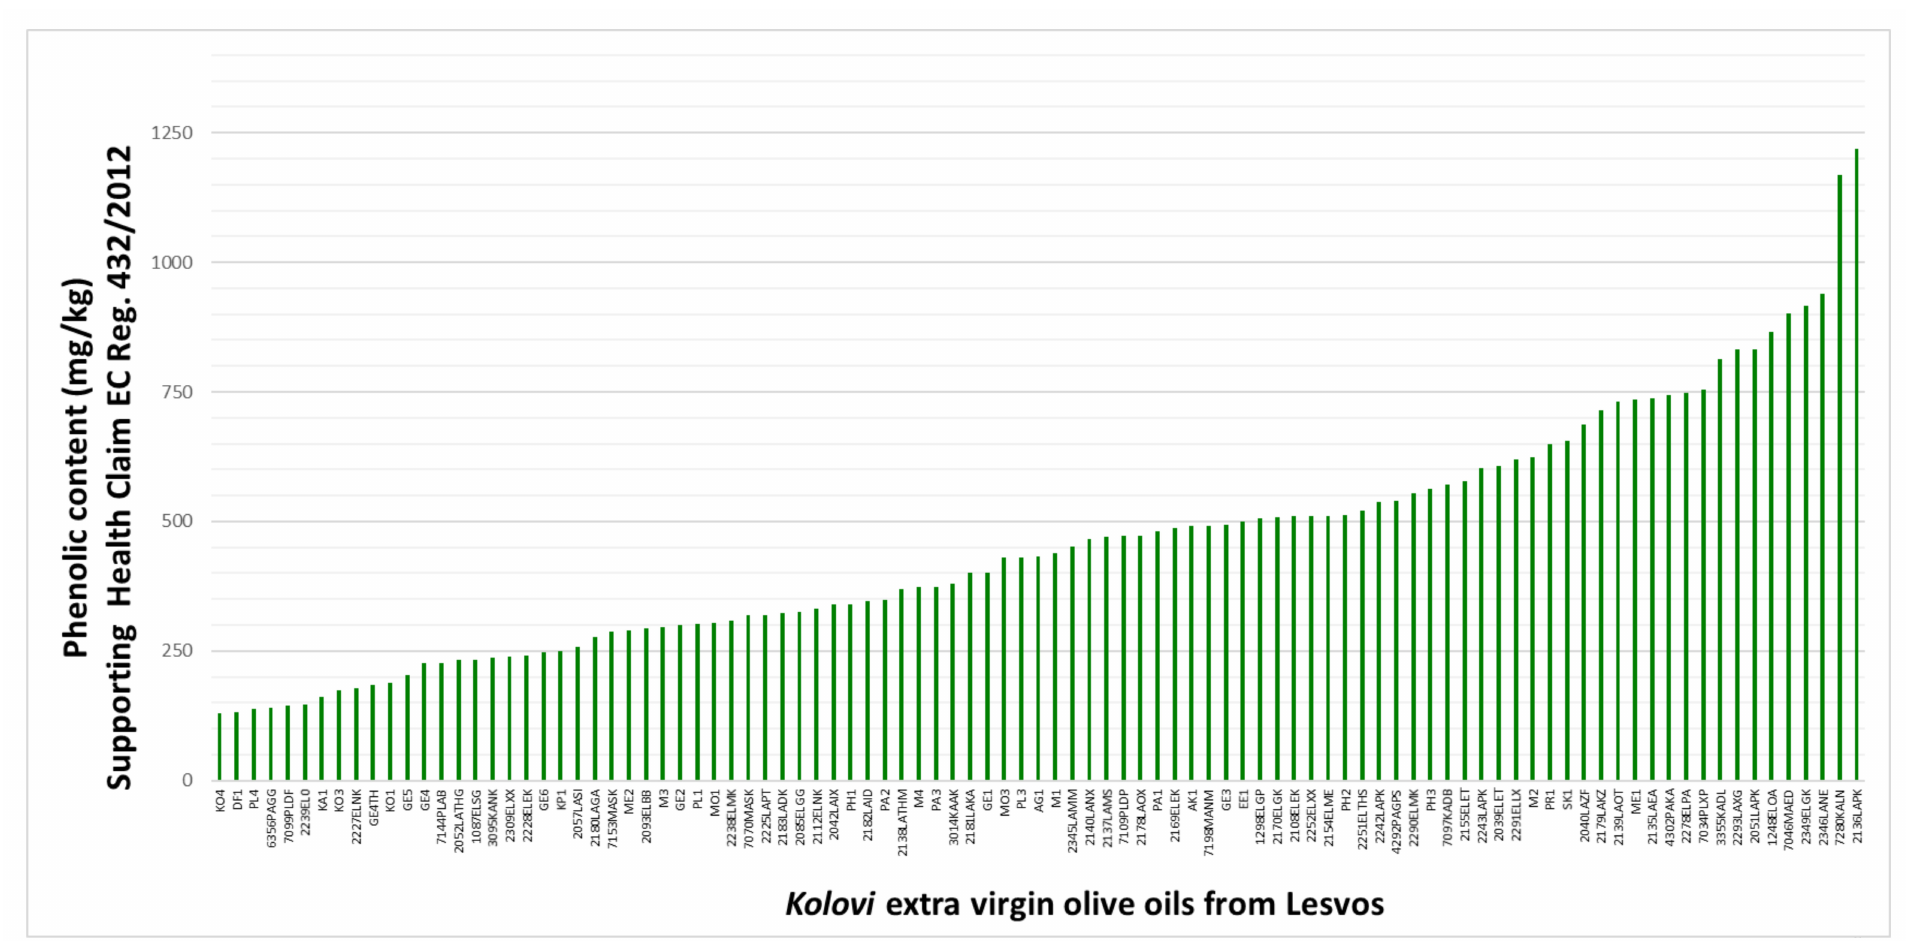
Figure 2. Phenolic content (mg/kg) of Kolovi EVOOs from